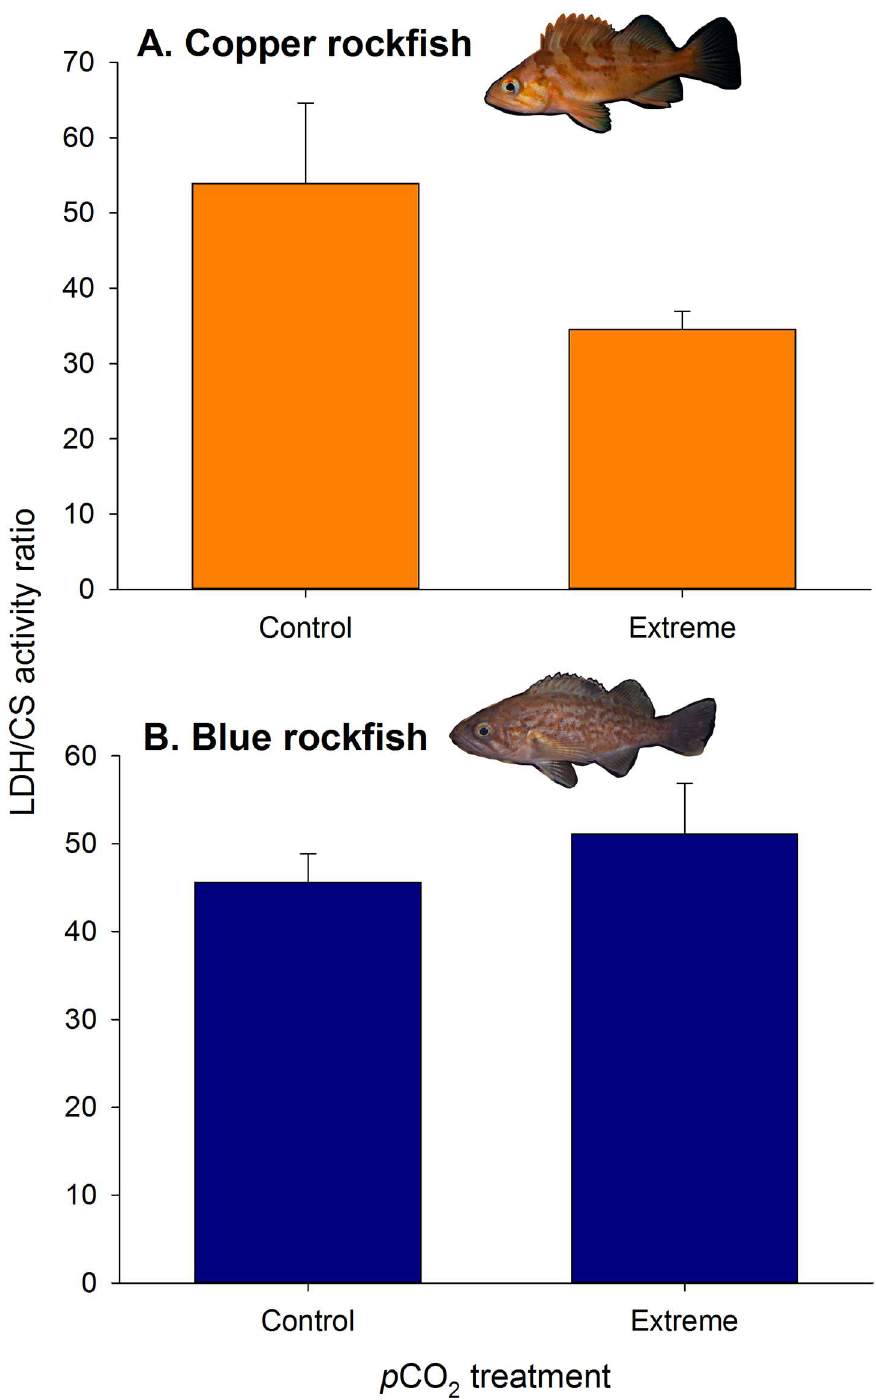
Fig 4. Enzyme activity ratios for lactate dehydrogenase and citrate synthase (LDH:CS) in white muscle tissue of (A) copper and (B) blue rockfish following chronic exposure to extreme p CO 2 (~2800 μ atms)or control (~550 μ atms)treatments. Copperrockfish exhibiteda significantincreasein aerobic enzyme activity relative to anaerobicactivity (i.e., lower LDH:CS ratio) from the control to extreme high p CO 2 treatments (two-way ANOVA; Species × Treatment: F 1 , 24 = 4.46, P = 0.045), whereasblue rockfish did not differ in LDH:CS activity among